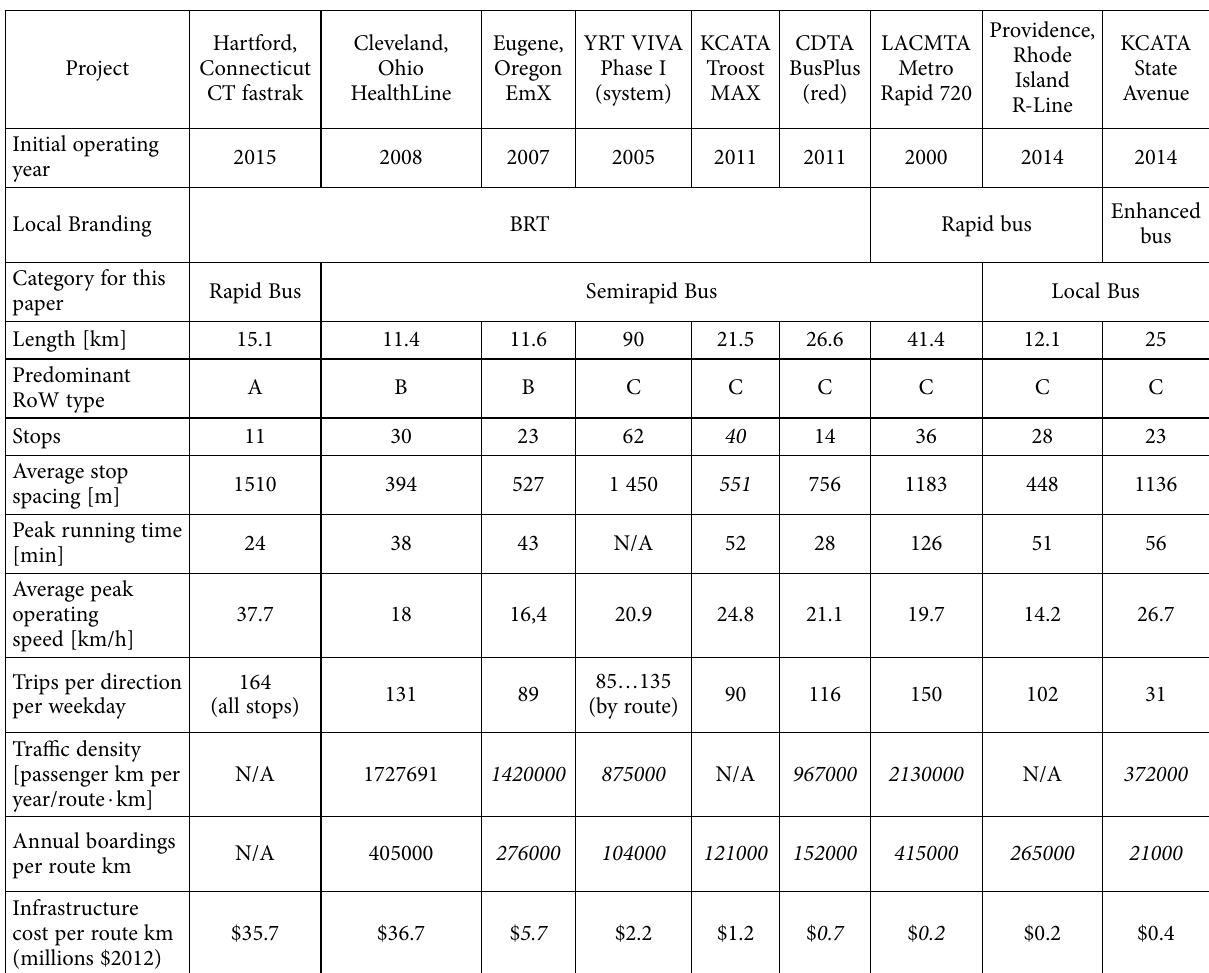
Table 1. Terminology vs. characteristics of some different bus